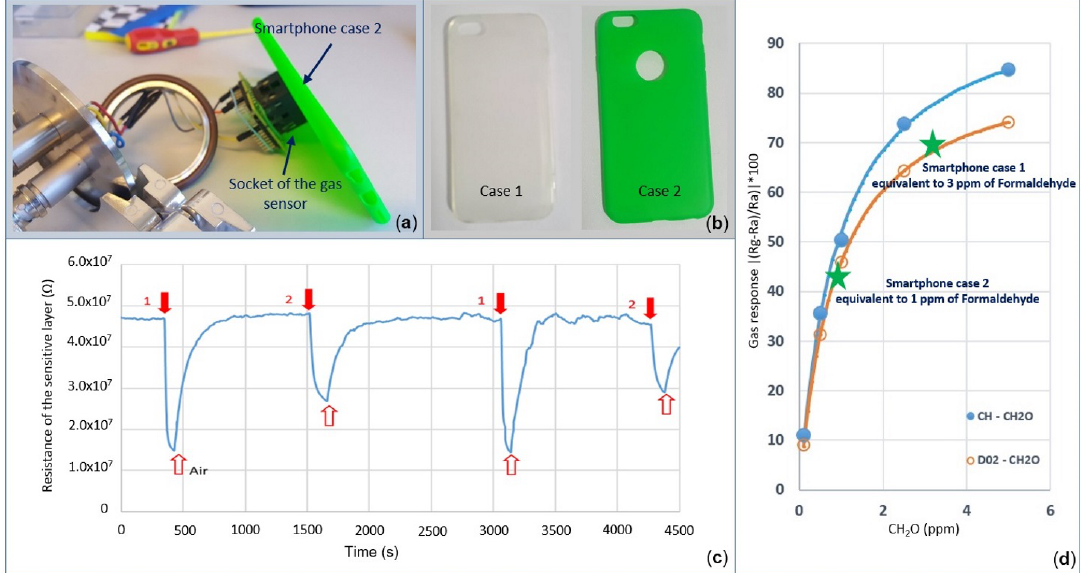
Figure 12. Response of the gas sensor while operating near the rubber smartphone cases in open air. ( a ) Characterization setup. ( b ) Two rubber smartphone cases used in this study. ( c ) Resistance of the sensitive layer of the D02 gas sensor in the presence of rubber smartphone cases. ( d ) Equivalent response of the smartphone covers when equated to